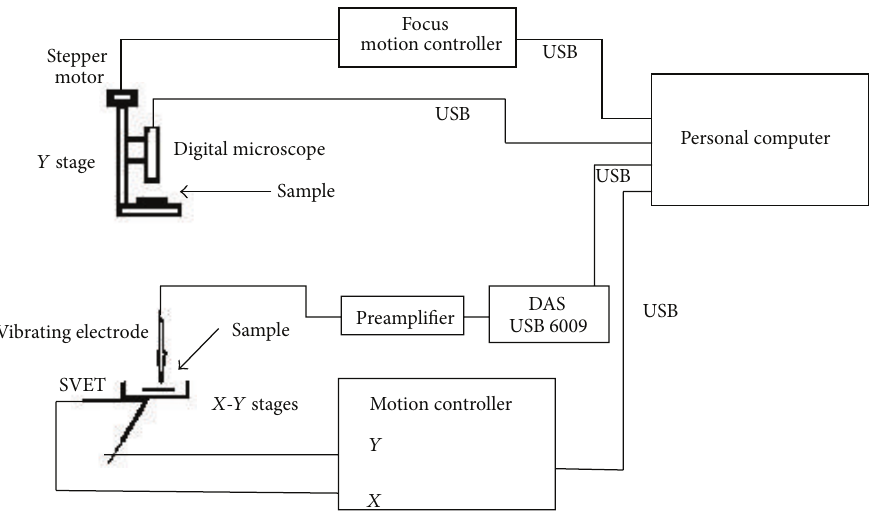
Figure 1: VI LCIA system